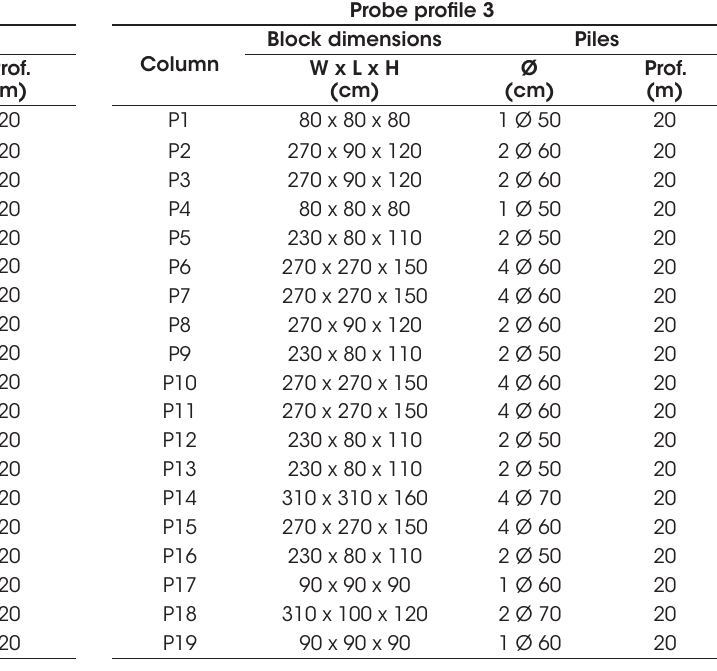
Data of the foundations of the 8-floor building Probe profile